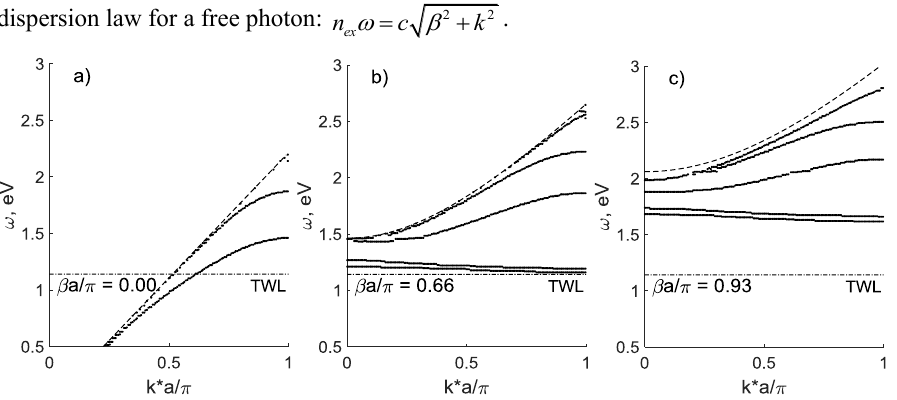
Fig. 3. The dispersion law for the guided modes with different propagation constants.